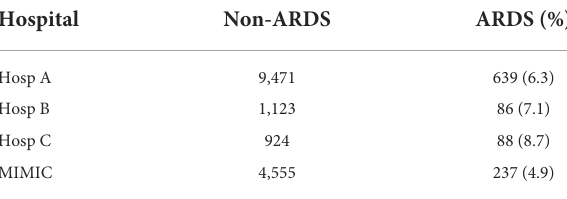
TABLE 2 Number of day 1 non-ARDS/ARDS patients in